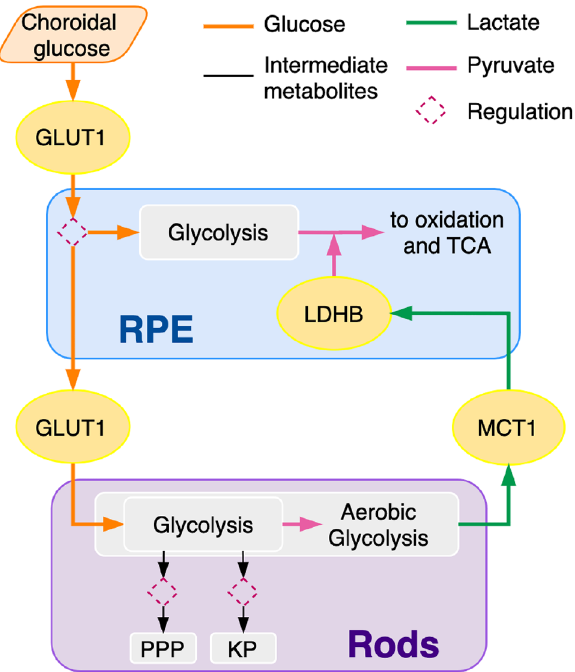
Figure 1. Diagram of key metabolic pathways (glycolysis, aerobic glycolysis, penthose phosphate pathway (PPP), and Kennedy pathway (KP)), transporters (GLUT1, MCT1), enzymes (lactate dehydrogenase B (LDHB)), and feedback metabolite flow between the RPE and the rods considered in our model. The metabolic pathway blocks represent several enzymatic reactions, and each reaction uses a specific metabolite as substrate to produce another metabolite. The RPE transports glucose from the choroid into the photoreceptors and keeps only a small portion to be converted into pyruvate through glycolysis. The transport is enabled by GLUT1. Once in the photoreceptors, glucose enters the glycolysis pathway from which intermediate metabolites are directed to the PPP and KP. Pyruvate, the end product of glycolysis, is reduced into lactate by aerobic glycolysis in the rods. Lactate is cleared from the rods, and transported to the interphotoreceptor matrix by MCT1, which also transports it into the RPE. Inside the RPE, lactate is converted to pyruvate by LDHB to be oxidized and processed by the tricarboxylic acid cycle, also known as the Krebs